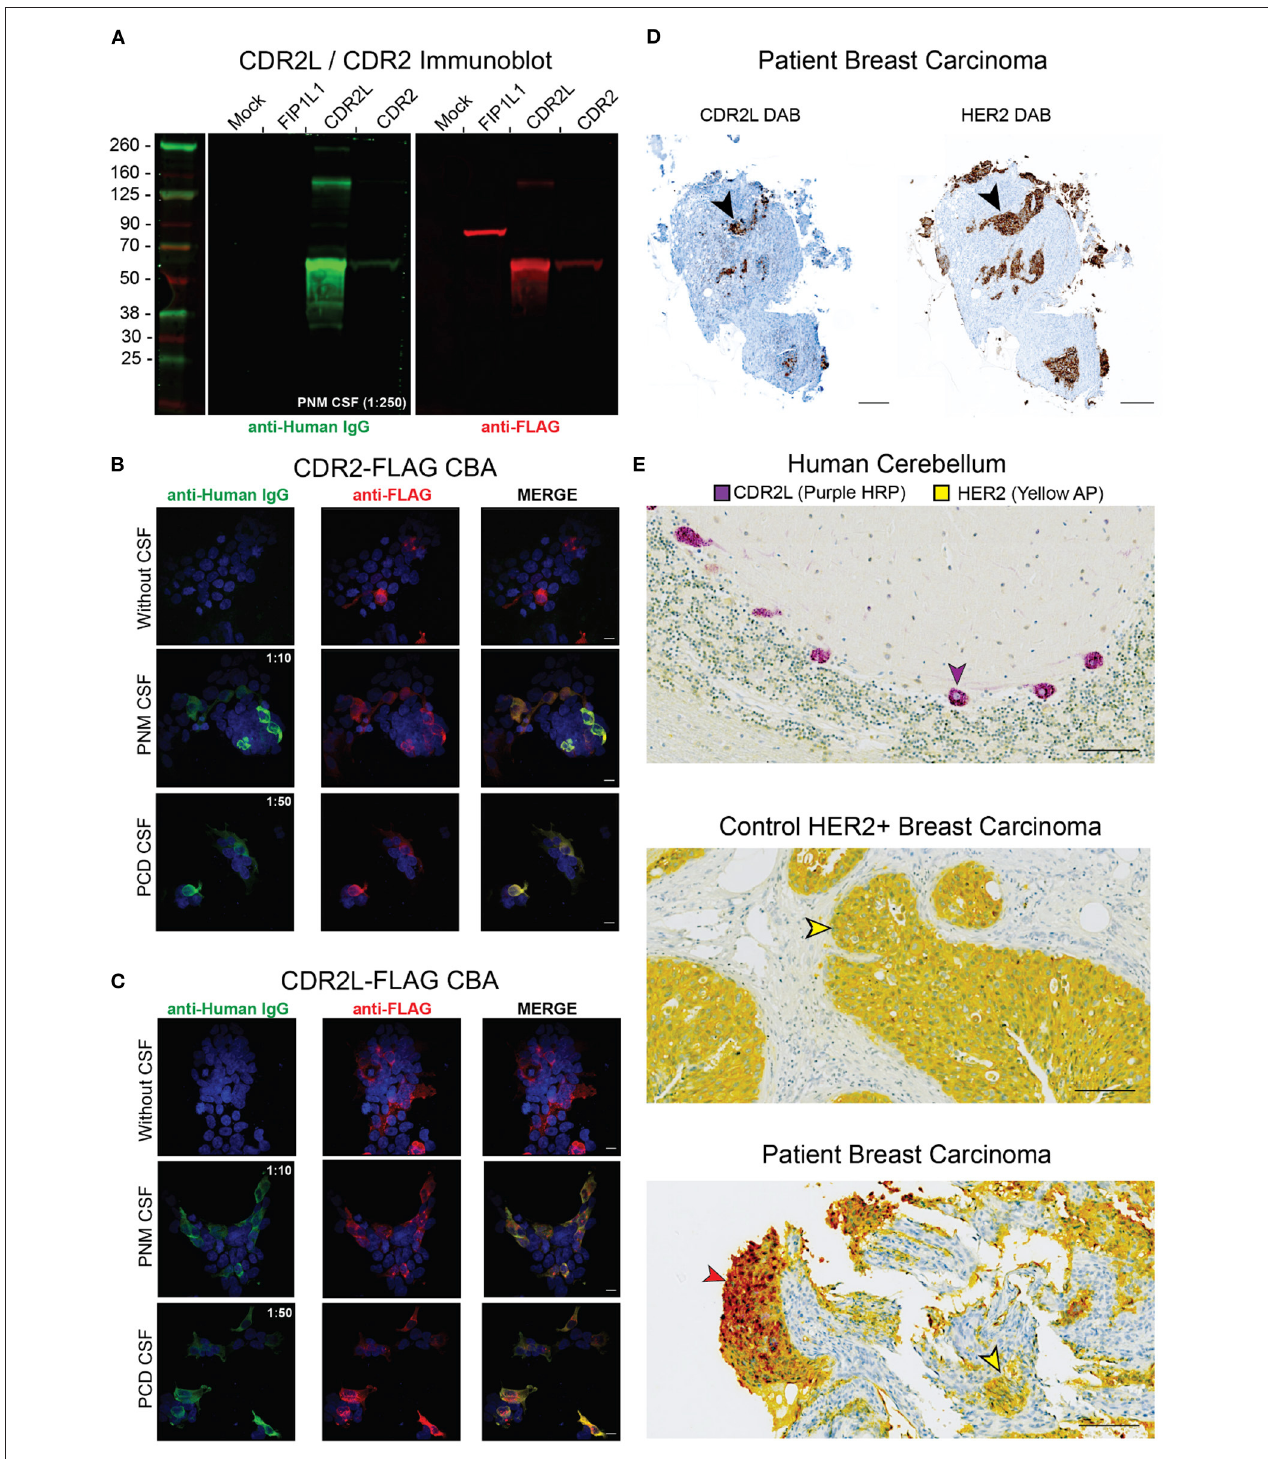
FIGURE 3 | Validation of anti-Yo antibodies in PNM CSF. (A) HEK293T cells were transfected with FIP1L1-FLAG, CDR2L-FLAG, or CDR2-FLAG. Lysates were separated by SDS-PAGE and resulting immunoblots were probed with PNM CSF (green, 1:250) and counterstained with an anti-Human IgG 800CW secondary antibody (green). The membrane was the probed with anti-FLAG and anti-rabbit 680RD secondary antibody (red). PNM CSF IgG recognized recombinant CDR2L and CDR2 but not FIP1L1. (B) HEK293T cells were transfected with CDR2-FLAG and immunostained with PNM CSF at 1:10, PCD CSF at 1:50 (both green) and